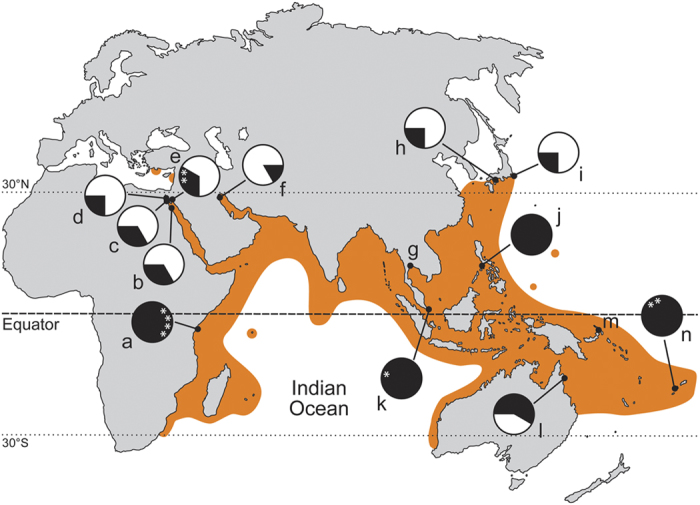
Distribution map and spawning periodicities of Diadema setosum.Locations of known spawning times are indicated by dots. Radial plots indicate estimated spawning periods (black portions) for each location. The plots are constructed of 12 equally sized slices representing the monthly annual cycle from January to December (clockwise). In sites of continuous year-round spawning, peak spawning months are indicated by asterisk (if such distinction was mentioned in the literature). Distribution estimates were based on: Pearse1257; Clark and Rowe58; Marsh and Marshall59; Rowe and Gates60; Shin61; Lessios et al.4; James62; Sastry63; Yokes and Galil64; Nader and El Indary65 as well as data available from the OBIS website (http://www.iobis.org/home). Lowercase letters indicate the underlying publication of spawning periodicities for the particular location (only publications specifically referring to spawning periodicities were considered for the construction of this map). a: Kenya - Muthiga18; b: Al-Ghardaqa - Pearse10; c: Wadi-el-Dom (Gulf of Suez)- Pearse10; d: Port Tawtiq (Gulf of Suez) - Fox46; e: Eilat (Gulf of Aqaba)- this study; f: Kuwait - Alsaffar and Lone17; g: Sichang (Thailand)- Kobayashi45 (report of spawning in a two month study during February and March) ; h: Seto (Japan)- Onoda66, Kobayashi and Nakamura67; i: Misaki (Japan)- Yoshida30; j: Philippines - Tuason and Gomez44; k: Singapore - Hori et al.31; l: Low Isles (Great Barrier Reef) - Stephenson68; m: Rabaul (New Britain Island) - Pearse12 (report of spawning by field observations on 24.02.1965 based on pers. comm. from J. J. Gonor); n: Fiji - Coppard and Campbell14. The map was created based on the Wikimedia Commons public domain map file BlankMap-World6.svg (https://commons.wikimedia.org/wiki/File:BlankMap-World6.svg) and manually edited using CorelDRAW x4.